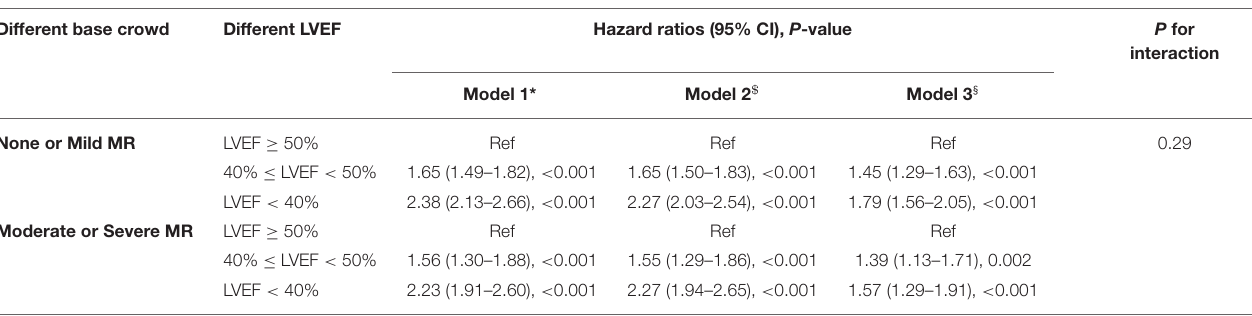
TABLE 2 | Cox proportional hazard ratios (HR) for long-term all-cause mortality. Different base